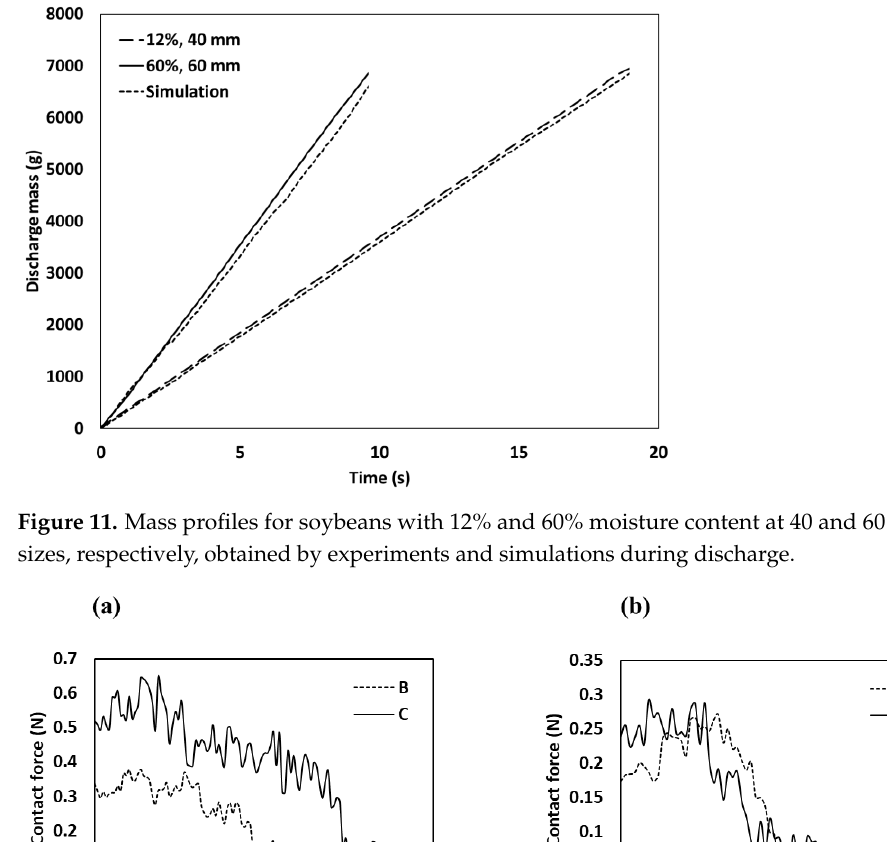
Figure 10. Discharge process in the simulation for the soybeans with 12% moisture content at 40 mm orifice size ( a ), and shapes of the soybean particles for DEM simulations of grains with 12% ( b ) and 60% ( c ) moisture contents.